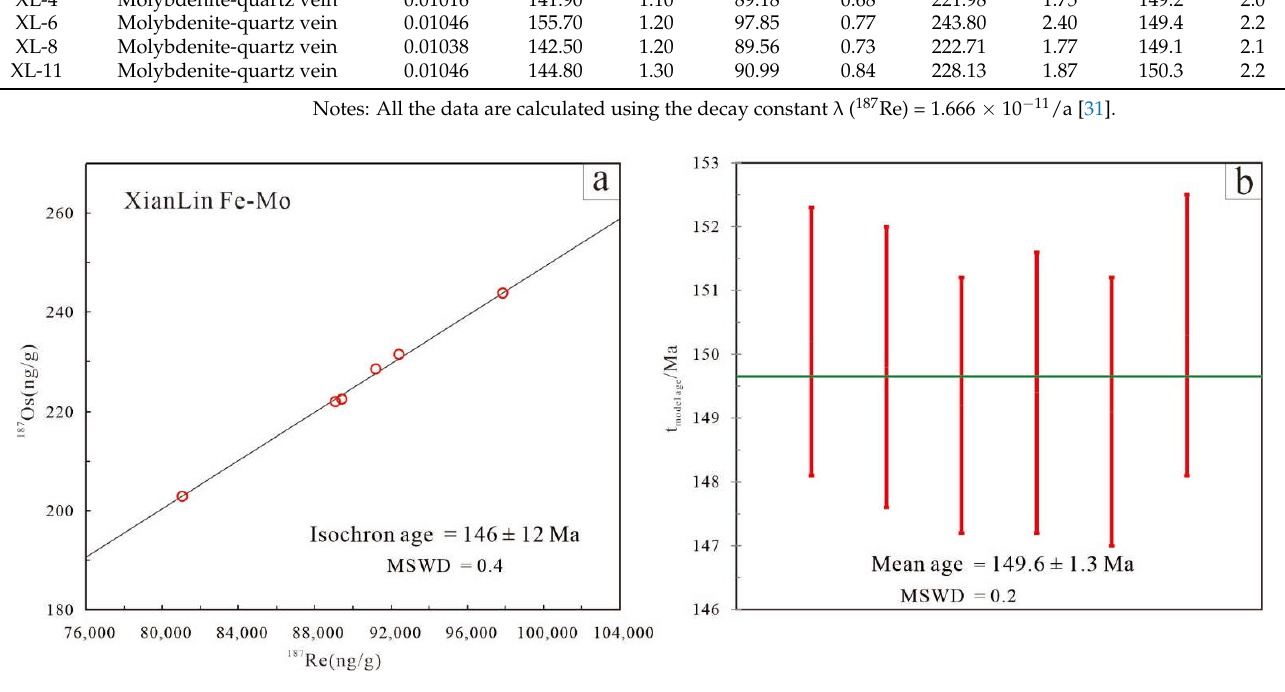
Figure 6. Re–Os isochron diagram ( a ) and mean age diagram ( b ) for molybdenite samples from the Xianlin Mo(Cu)-Fe